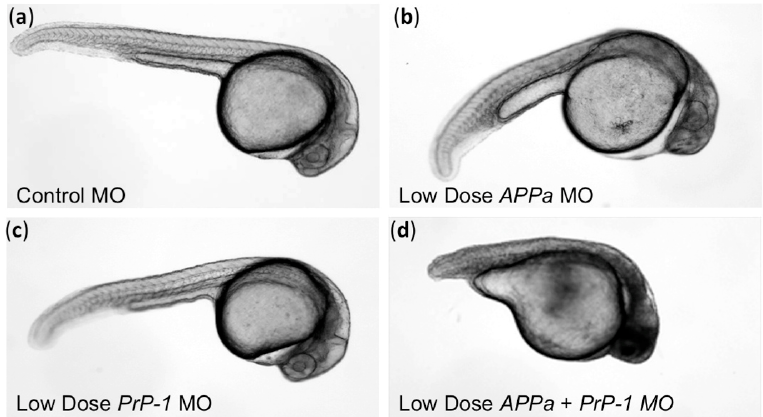
Figure 3. Loss of prion protein (PrP) induces neurodevelopmental phenotypes in zebrafish. Some of the functions revealed by morpholino (MO) knockdown of prion protein in zebrafish may overlap with the functions of Amyloid β Precursor Protein (APP), as suggested by the synergistic phenotype revealed when they are disrupted together. ( a ) Delivery of control morpholino (MO) reagents show typical zebrafish development; ( b , c ) Small reductions of either APP or PrP leads to subtle phenotypes and some CNS cell death (dark areas in head), whereas delivery of high dose APP MO induces more dramatic phenotypes; ( d ) Combining the low dose knockdown of APP and PrP leads to dramatic developmental defects. Human and mouse homologs of APP and PrP are able to rescue the phenotype in ( d ) when delivered to developing zebrafish. Numerous control experiments support the specificity of these reagents [43]. Images modified from [43].